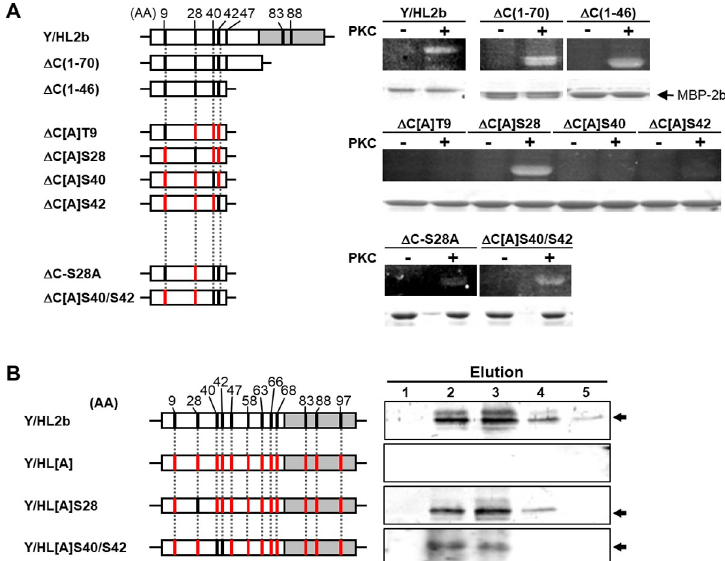
Fig 2. Mapping of phosphorylation sites of 2b. (A) Schematic structures of the 2b mutants expressed in E . coli and in vitro phosphorylation assay. White boxes: Y2b peptide sequence; gray boxes: HL2b peptide sequence. Black bars: serine (S) or threonine (T); red bars: alanine. When the mutant 2b backbone is the construct containing alanine-substituted residues on all the putative phosphorylation sites, the mutant names contain “[A]”. Purified mutant 2b proteins were co-incubated with (+) or without (-) PKC. Phosphorylated proteins were detected by phosphoprotein gel staining (upper panel); the same gel was stained with Coomassie brilliant blue (lower panel). (B) In vivo phosphorylation assay. White boxes: N-terminal half of Y2b; gray boxes: C-terminal half of HL2b. Black bars: putative phosphorylation residues (S, T or Y); red bars: alanine-substituted residues. Fraction numbers are above the lanes. Elution 1–5: Elution fraction 1–5. Arrows on right: phosphorylated 2bs.